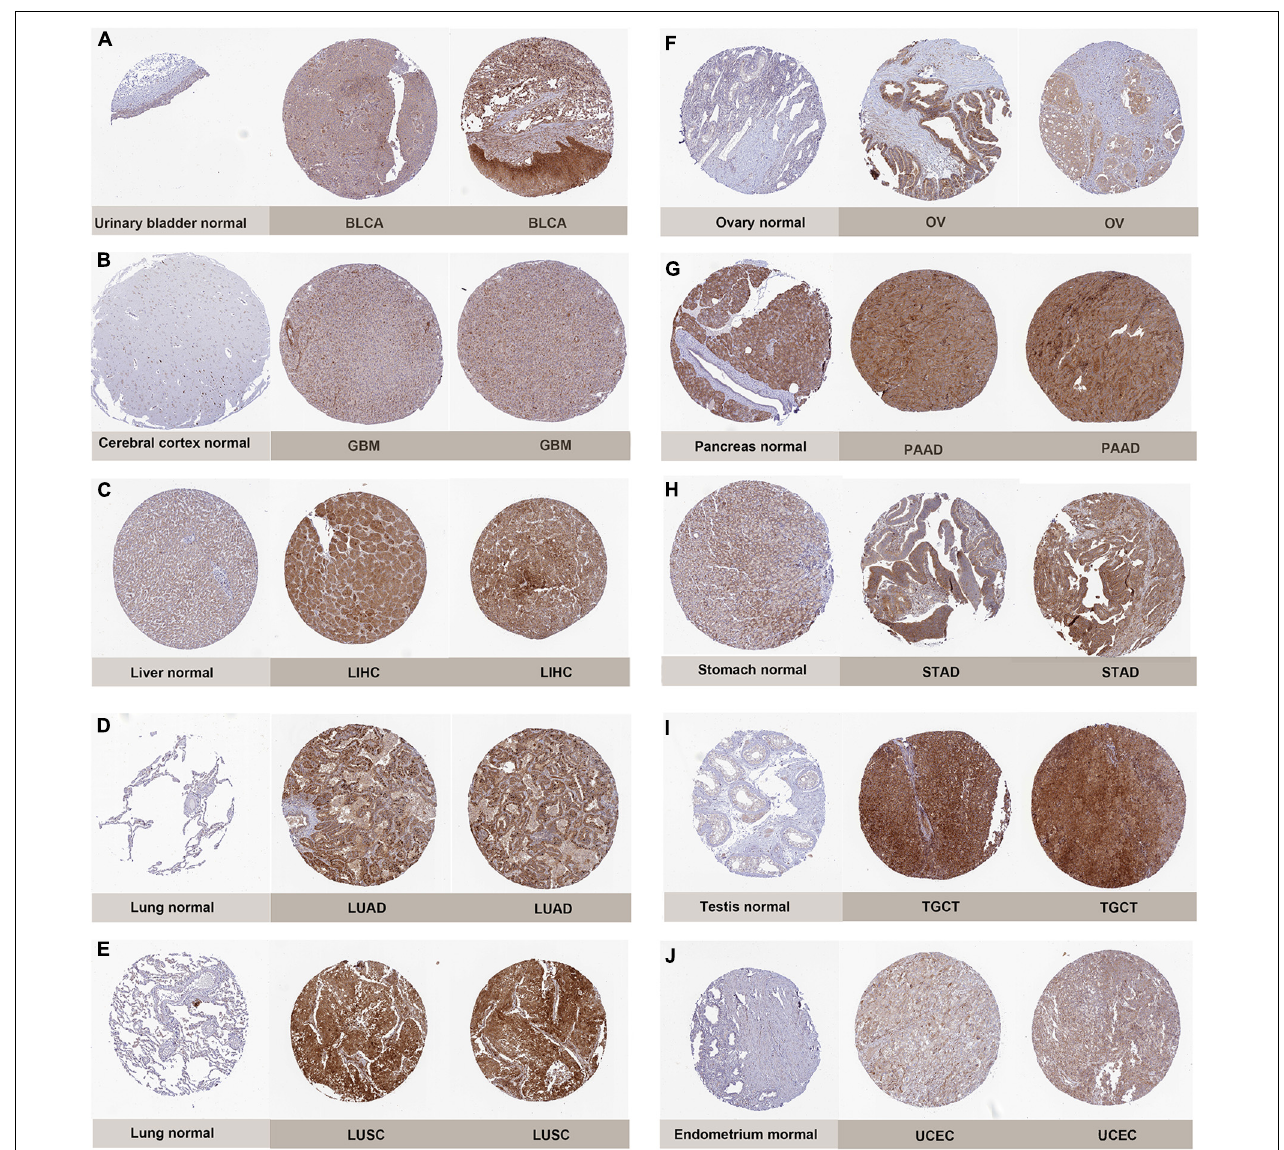
FIGURE 2 | Representative immunohistochemical stainings in various normal (left) and tumor (right) tissues. The protein expression of PIMREG was markedly higher in bladder Cancer (BLCA), glioblastoma (GBM), liver Cancer (LIHC), lung adenocarcinoma (LUAD), lung squamous cell carcinoma (LUSC), ovarian cancer (OV), pancreatic cancer (PAAD), stomach cancer (STAD), testicular cancer (TGCT) and endometrioid cancer (UCEC). (A) Urinary bladder. (B) Cerebral cortex. (C) Liver. (D,E) Lung. (F) Ovary. (G) Pancreas. (H) Stomach. (I) Testis. (J) Endometrium.